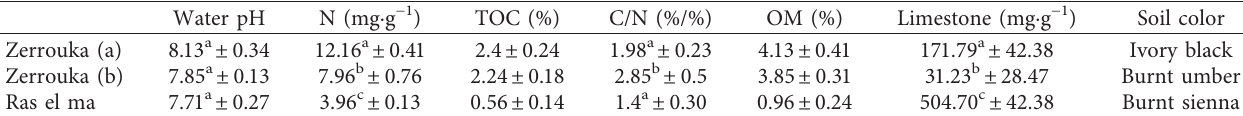
Table 4: Chemical characteristics of